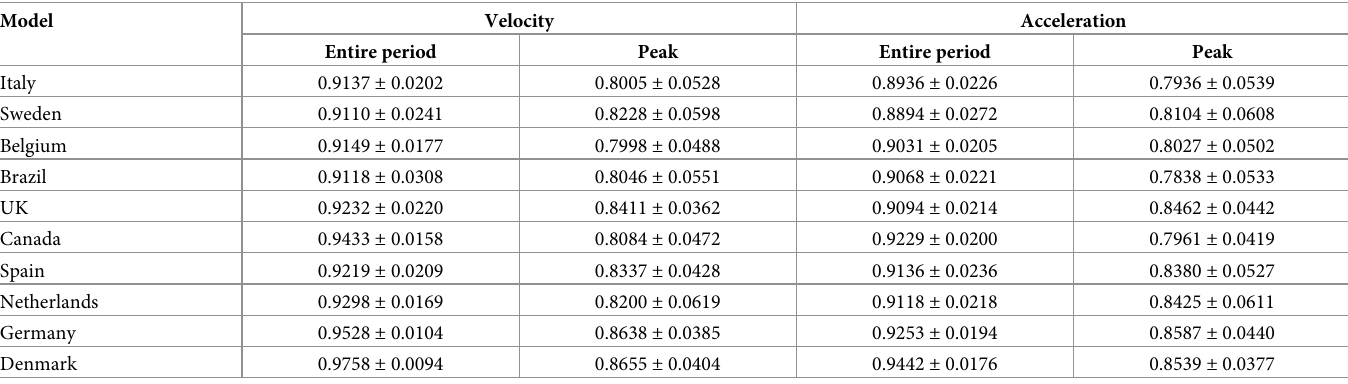
Table 6. Average Jaccard Index of factors comprising the models of two consecutive outbreak